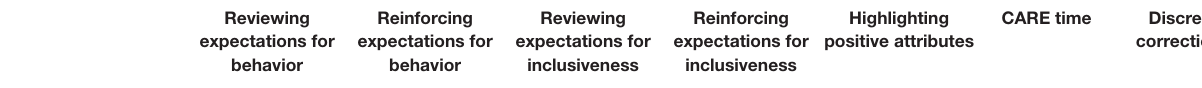
TABLE 4 | Summary of analyses for Aim